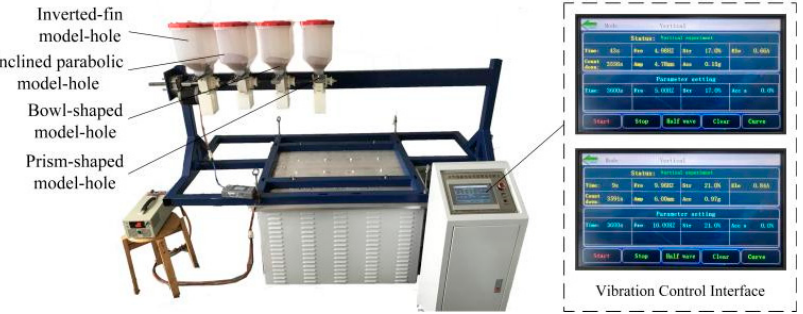
Figure 9. Optimum test bench for model-hole type.